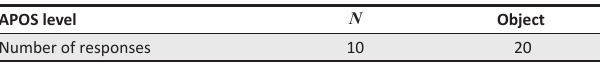
TABLE 7: Frequency of students’ responses for task 1c (i) according to APOS level.